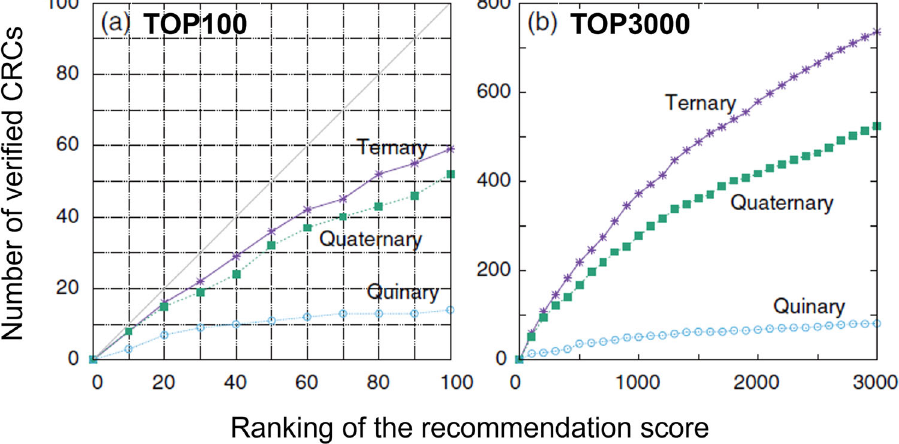
Fig. 5 The cumulative numbers of veri fi ed CRCs with the ranking of the recommendation scores for ternary, quaternary and quinary systems. a The top 100 candidates. b The top 3000 candidates. Adopted from ref. 14 with small modi fi cations.